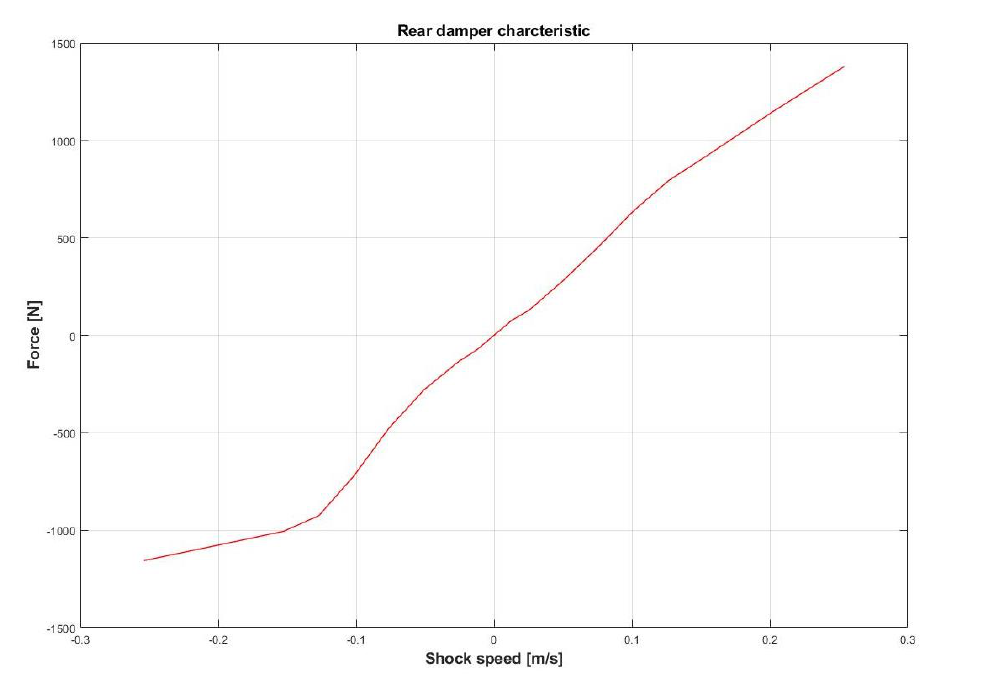
Figure 6. Rear damper characteristic.